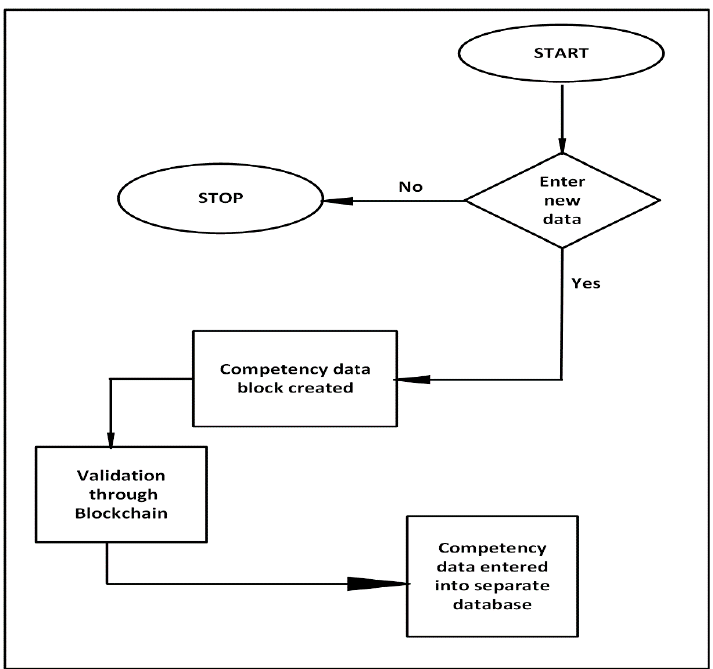
Figure 11. The process of collecting data on employee competencies in the block network.